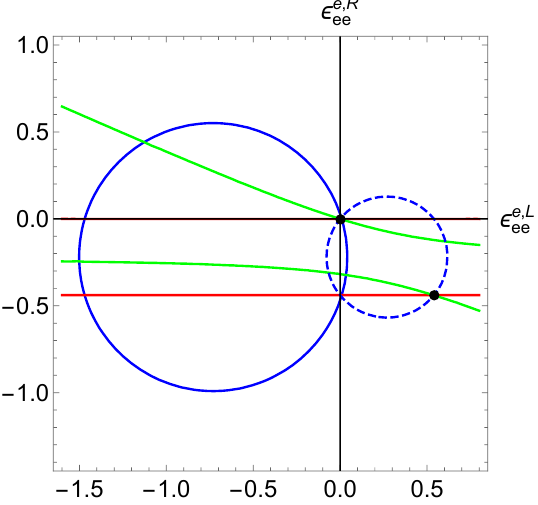
Figure 14 . SM degeneracy curves for each term in the E r expansion in the E (cid:23) ES cross-section are shown. The black points indicate where the sets of curves intersect, corresponding to the NSI solutions for (cid:15) e;L and (cid:15) e;R that leave the E (cid:23) ES cross-section degenerate with the (cid:11)(cid:12) (cid:11)(cid:12)